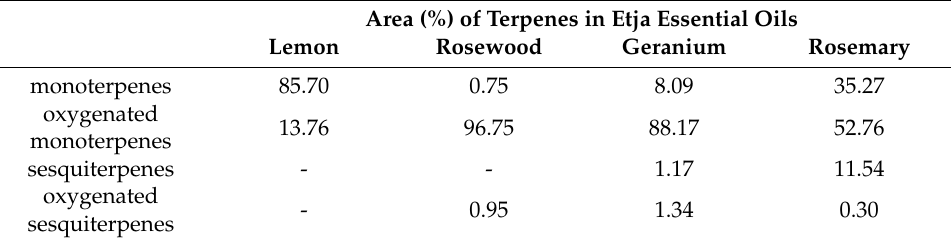
Table 1. The contents of terpenes (%) in the tested essential oils.